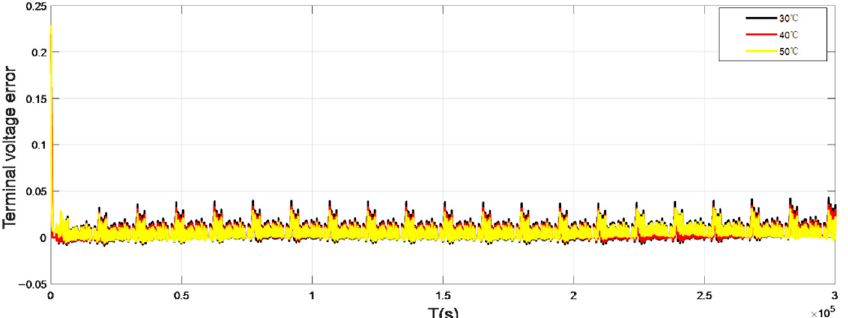
Figure 6. Terminal voltage error curve at high temperature.